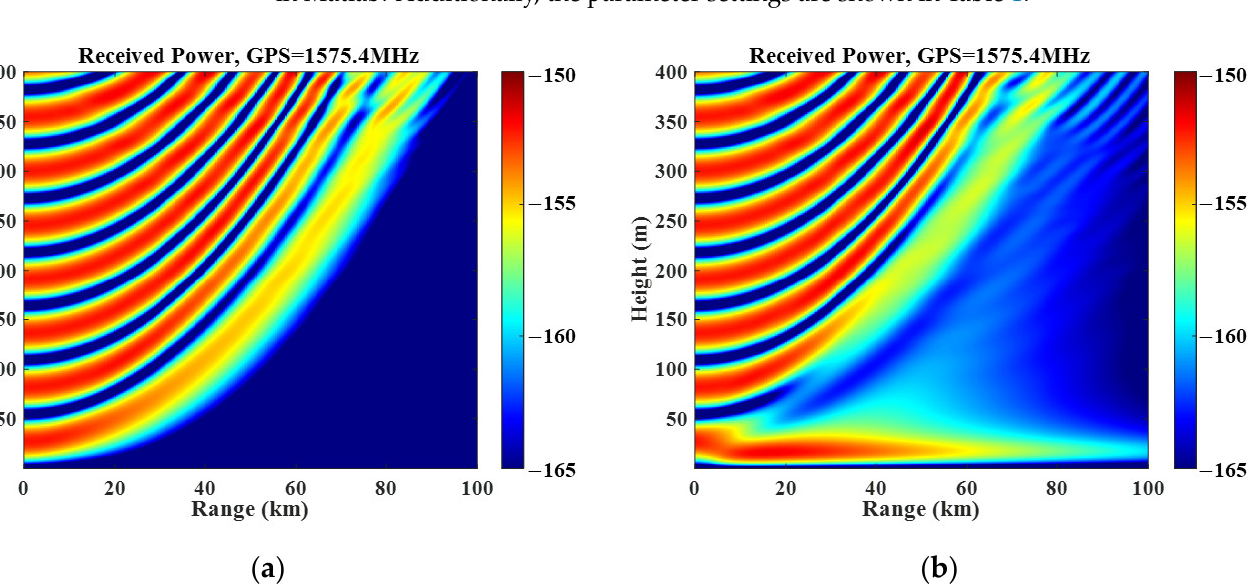
Figure 3. GPS-received power. ( a ) Standard atmosphere; ( b ) Evaporation duct.